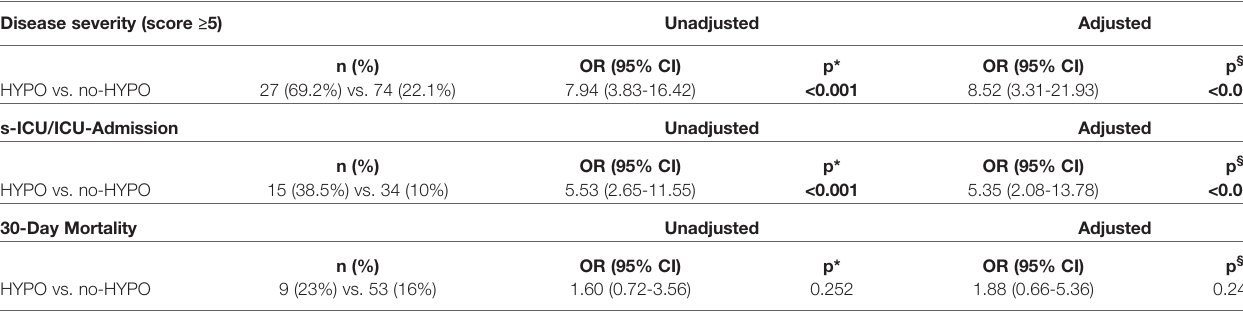
TABLE 4 | Primary outcomes in the overall population. Disease severity (score ≥ 5)